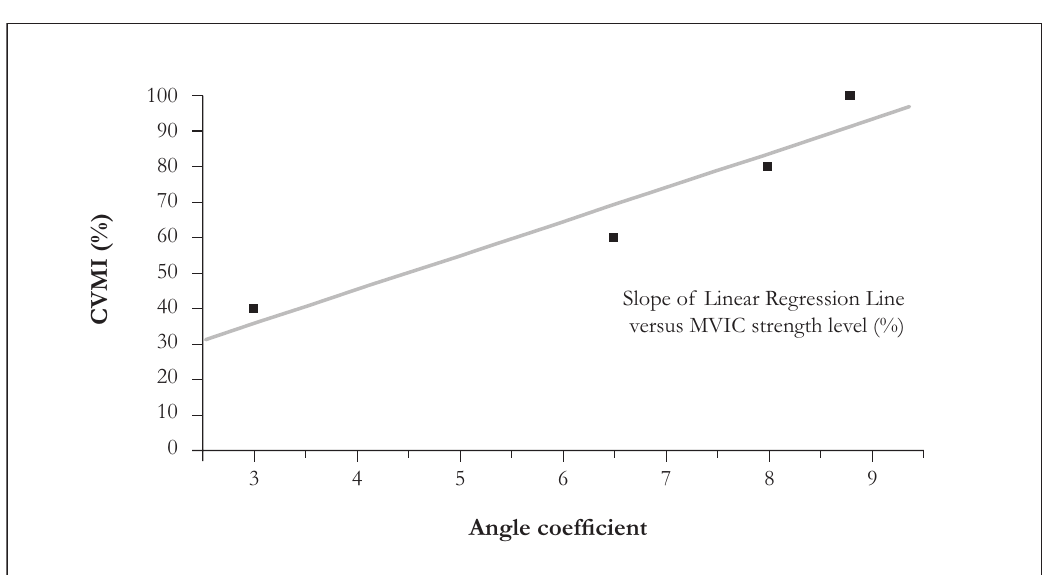
Figure 4 - Slope of linear regression line (determined by Pearson’s test) for median frequency of each strength level measured for the Vastus lateralis of Volunteer 1 (abscissa axis) crossed with respective strength levels (ordinate axis). The linear regression line obtained by the slope of each strength level (100, 80, 60, 40% of MVIC) establishes a new linear regres- sion line, which crosses the ordinate axis (percentage of strength level), demonstrating